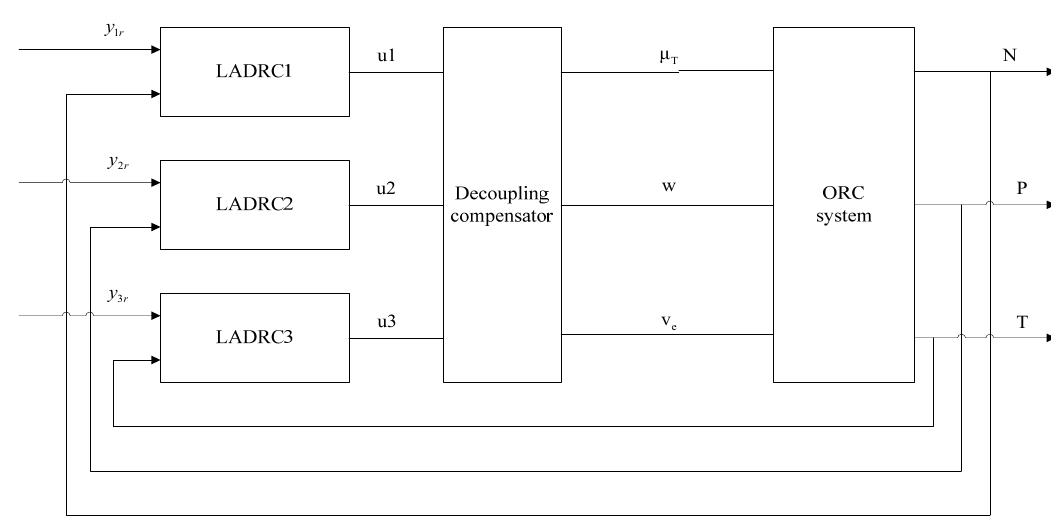
Figure 2. LADRC for the waste heat recovery